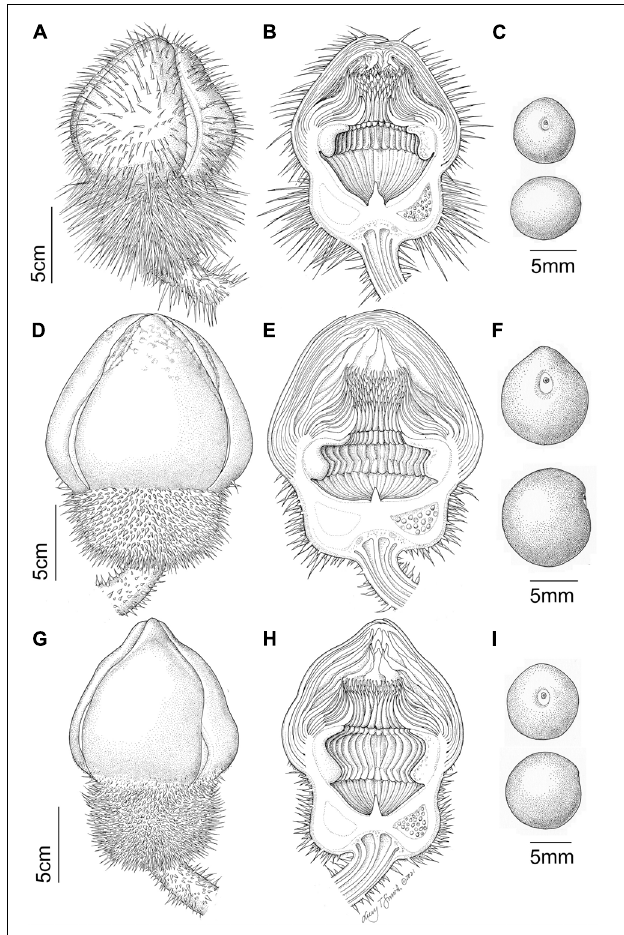
FIGURE 3 | Line drawing comparing flower and seed morphology in: Victoria amazonica (A–C) , V. boliviana sp. nov. (D–F) , and V. cruziana (G–I) ; flower bud whole and in longitudinal section showing abaxial surface of outer tepals, bud profile, stigmatic chamber, carpellary appendage and prickle morphology; seeds. (cultivated at RBG Kew) Illustration: Lucy T